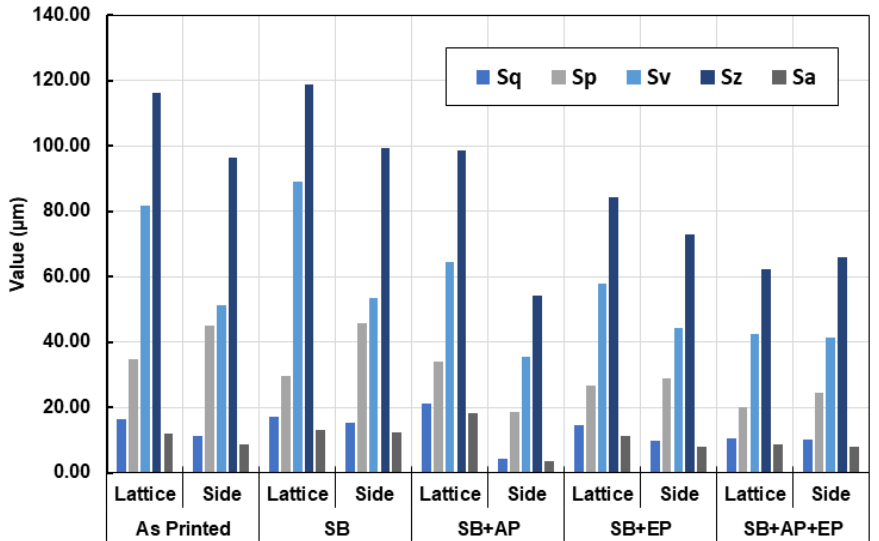
Figure 19. Measured conventional height parameters for the lattice joints and side planar surfaces. (Sq: root mean square height, Sp: maximum peak height, Sv: maximum pit height, Sz: maximum height, Sa: arithmetical mean height, SB: Sandblasting, AP: Abrasive Polishing, EP: Electropolishing.).